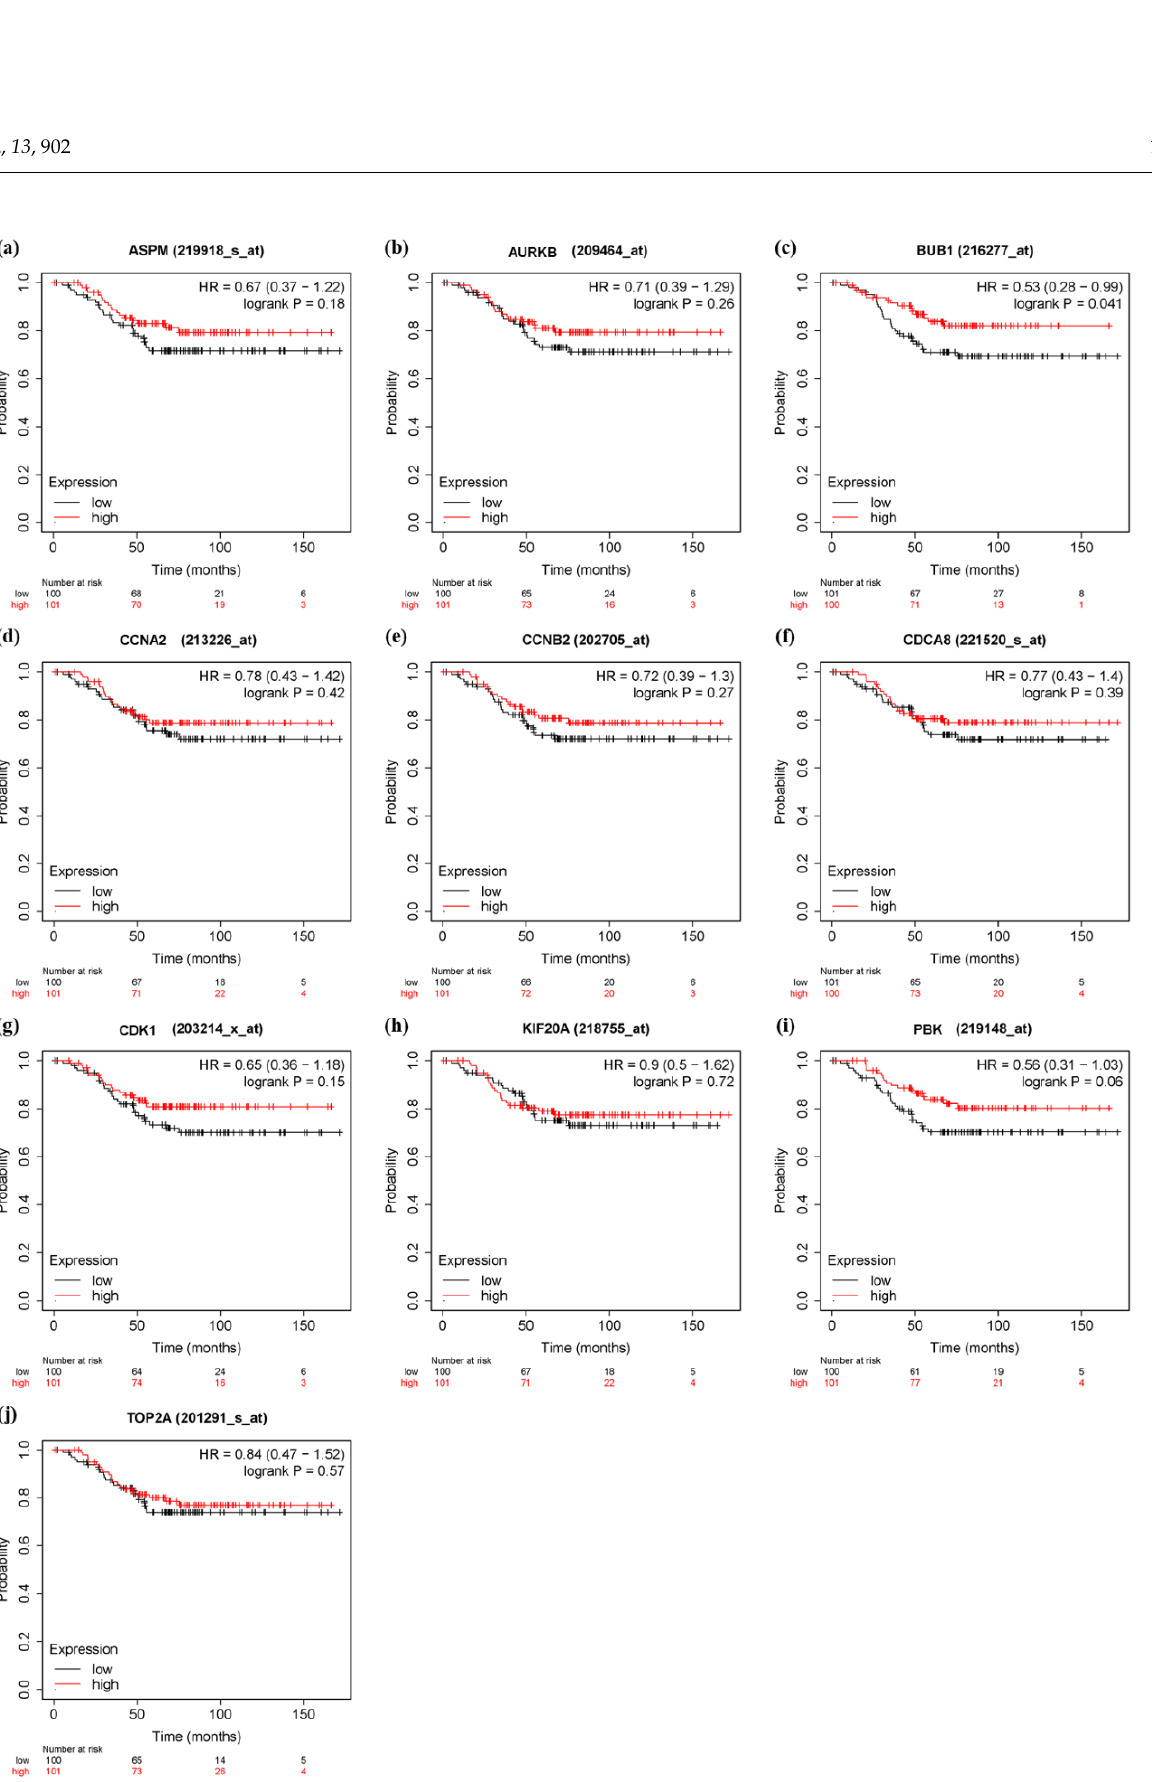
Figure 10. Overall survival (OS) analysis of 10 hub genes in TNBC patients by KM Plotter. ( n = 201) ( a ) ASPM ( b ) AURKB ( c ) BUB1 ( d ) CCNA2 ( e ) CCNB2 ( f ) CDCA8 ( g ) CDK1 ( h ) KIF20A ( i ) PBK ( j ) TOP2A.